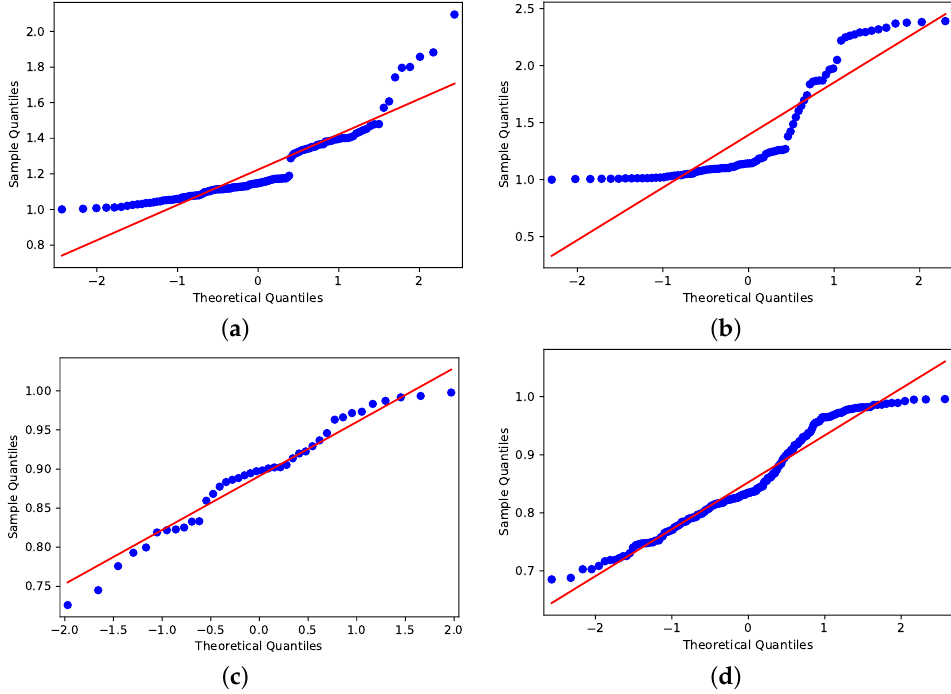
Figure 11. Shapiro–Wilk outcomes. ( a ) Holiday period with R 0 > 1. ( b ) Not holiday period with R 0 > 1. ( c ) Holiday period with R 0 < 1. ( d ) Not holiday period with R 0 < 1.